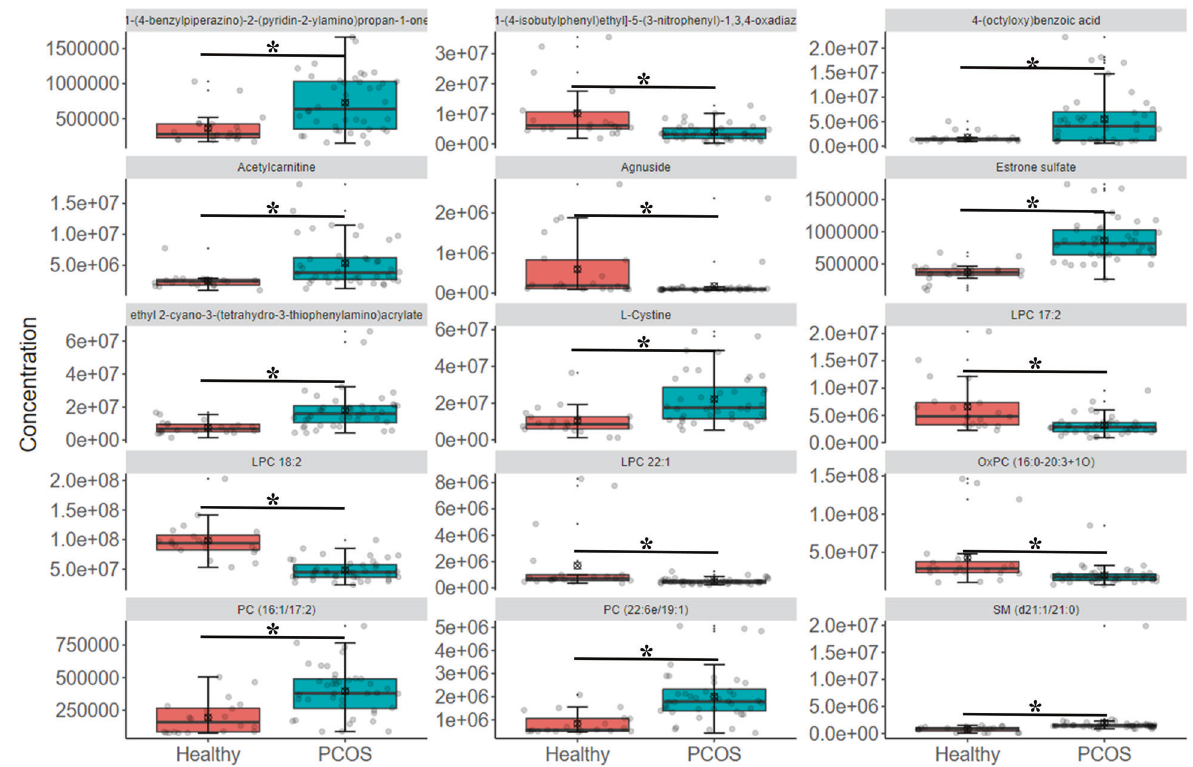
Fig. 4 The distribution of distinguished metabolites in PCOS patients. The metabolites were screened out based on metabolites with VIP > 1, p < 0.05, and FC ≥ 2 or FC ≤ 0.5. Red and green color represent Healthy and PCOS group separately. * p < 0.05 denotes signi fi cant difference. The data are shown as the mean ± SD and error bar was used.